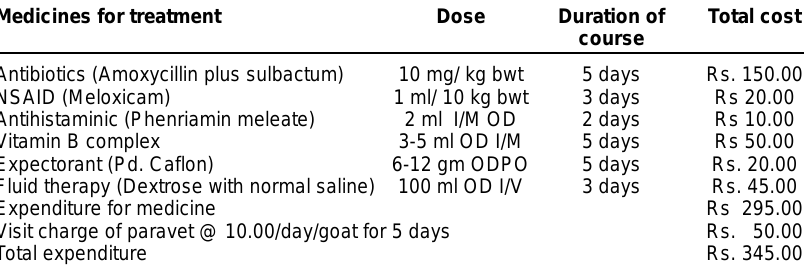
Table-2. Treatment cost of PPR affected